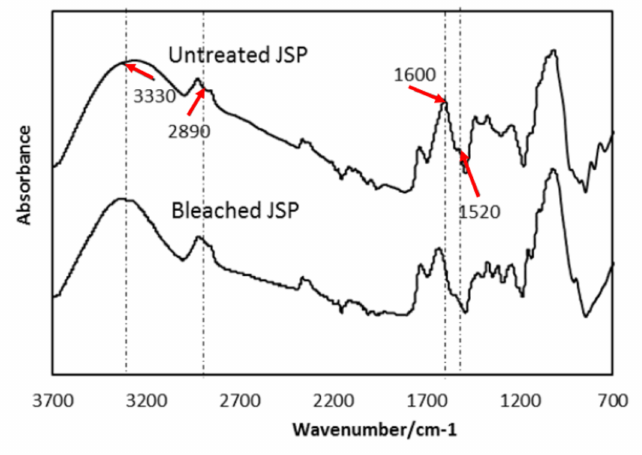
Figure 4. Fourier-transform infrared (FTIR) spectrum for JSP and